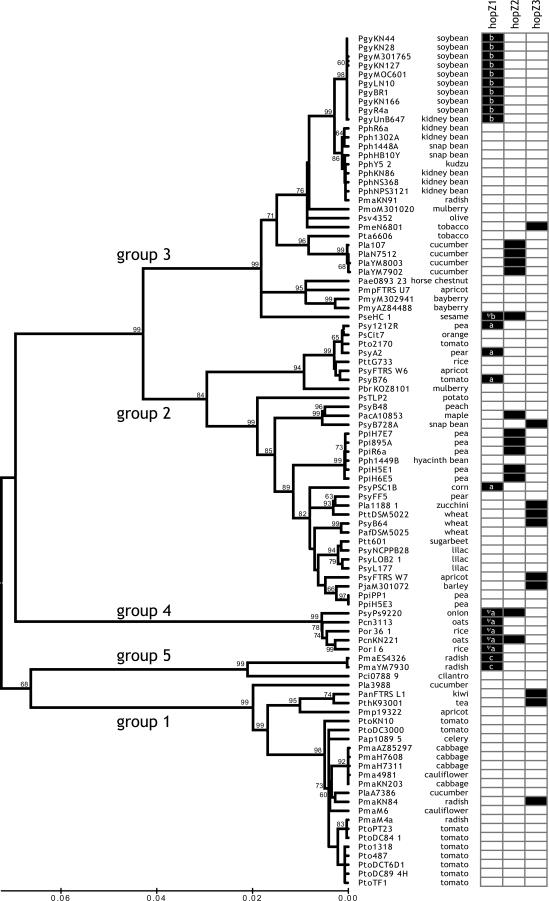
Distribution of HopZ T3SEs in the P. syringae Species ComplexThe distribution of HopZ T3SEs in relation to the core genome phylogeny of 96 natural P. syringae isolates. The phylogenetic tree (neighbor-joining, 1,000 bootstrap) was generated by MLST of four housekeeping genes. The host of isolation is presented to the right of each strain. See [40,65] and Table S1 for details. Black squares represent presence of the corresponding gene, whereas white ones represent absence. hopZ1 alleles are annotated. The full sequence of hopZ1aPsyB76 was not obtained although its expression was confirmed.